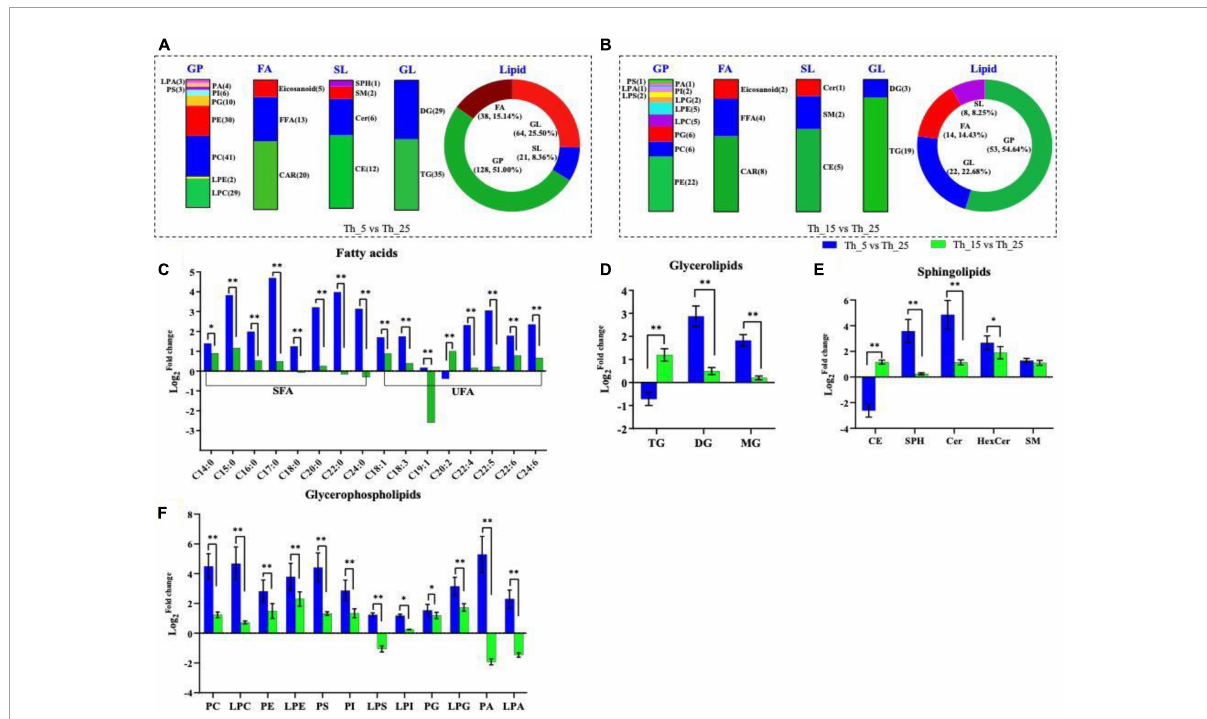
FIGURE2 Lipid composition under different temperature treatment. Differential identified lipid numbers in Th_5 vs. Th_25 (A) and Th_15 vs. Th_25 (B) . Comparison of different fatty acids (C) , glycerolipids (D) , sphingolipids (E) , glycerophospholipids (F) among h_5 vs. Th_25 (blue column) and Th_15 vs. Th_25 (green column). FAL, fatty acyls; GL, glycerolipids; SL, sphingolipids; GP, glycerophospholipids; TG, triglycerides; DG, diglycerides; MG, monoglyceride; CE, cholesterol; SPH, sphingosine; Cer, ceramide; HexCer, glycoceramides; SM, sphingomyelin (The